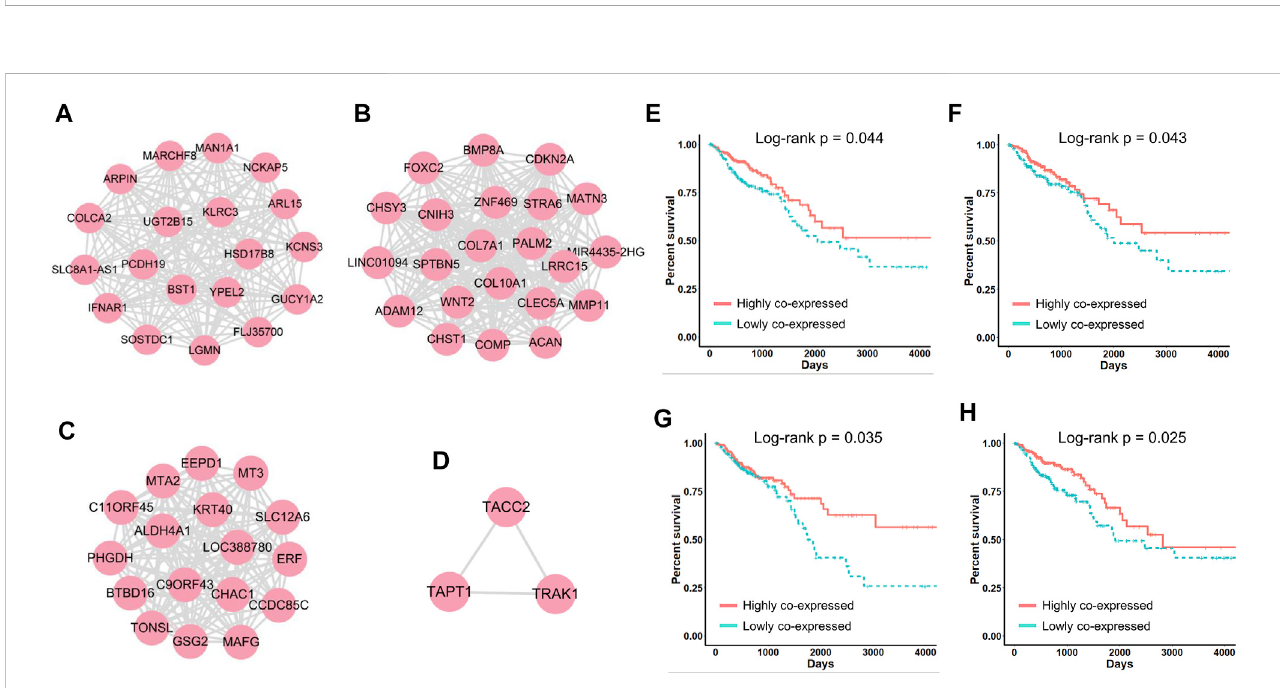
FIGURE 5 (A – D) Four networkscorrelated with CRC patient survival. (E – H) Kaplan ‒ Meier survival curves generated byperforming module-based survival analyses on networks (A – D)